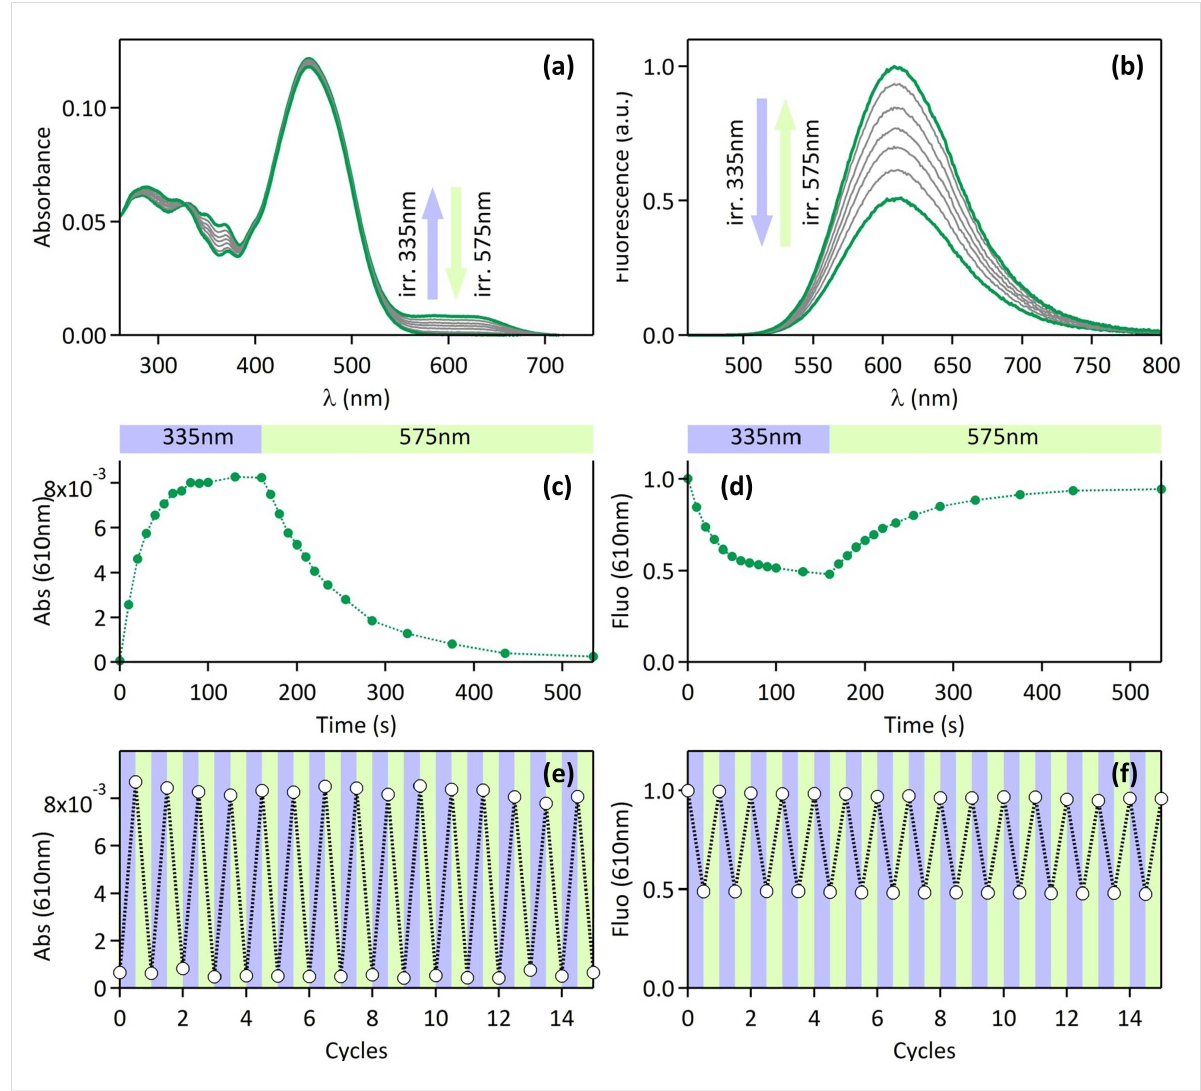
Figure 4: Absorption and fluorescence changes of compound 2 (1.0 μ M in CH 3 CN) upon UV–visible irradiation: (a) absorption and (b) emission spectra ( λ exc = 450 nm) under increasing irradiation times at 335 nm; (c) time-evolution profile of absorption and (d) emission upon irradiation at 335 nm and 575 nm; (e) fatigue resistance followed by the absorption band at 610 nm and (f) the emission band at 610 nm under alternate 355 nm/ 575 nm irradiation cycles. Irradiation conditions at 335 nm: (a–d) 2.7 mW cm − 2 and (e,f) 40 s at 7.2 mW cm − 2 . Irradiation conditions at 575 nm: (a–d) 3.1 mW cm − 2 and (e,f) 120 s at 9.5 mW cm − 2 .